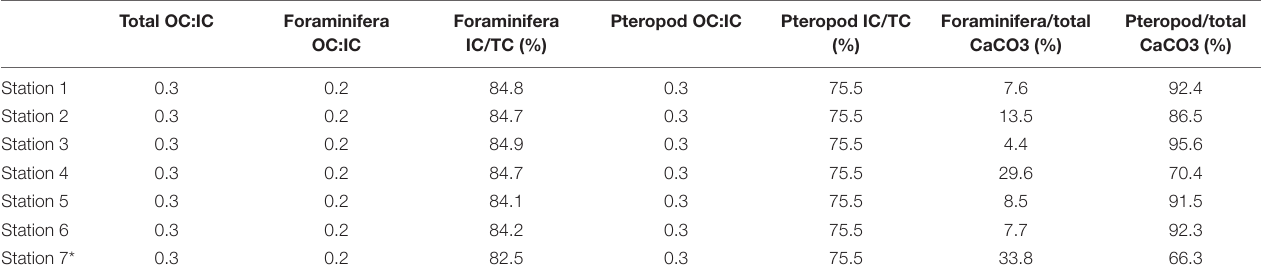
TABLE 8 | Total, and foraminiferal and pteropod organic:inorganic carbon ratio, foraminifera and pteropod inorganic contribution to the total carbon and foraminifera and pteropod inorganic contribution to the total inorganic standing